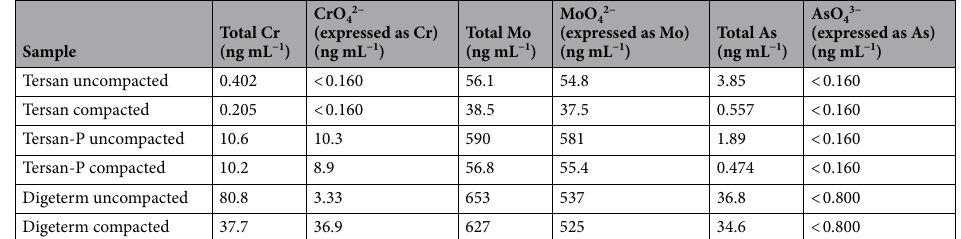
Table 4. Total concentrations of Cr, Mo and As in lysimetric water from uncompacted and compacted Tersan, Tersan-P and Digeterm geotechnical composites determined by ICP-MS, and concentrations of chromate, molybdate and arsenate determined by HPLC-ICP-MS. The results represent the average of three determinations of total Cr, Mo and As concentrations and concentrations of chromate, molybdate and arsenate. Measurement uncertainty for ICP-MS is better than ± 1.5%, while for the HPLC-ICP-MS better than ± 5%.